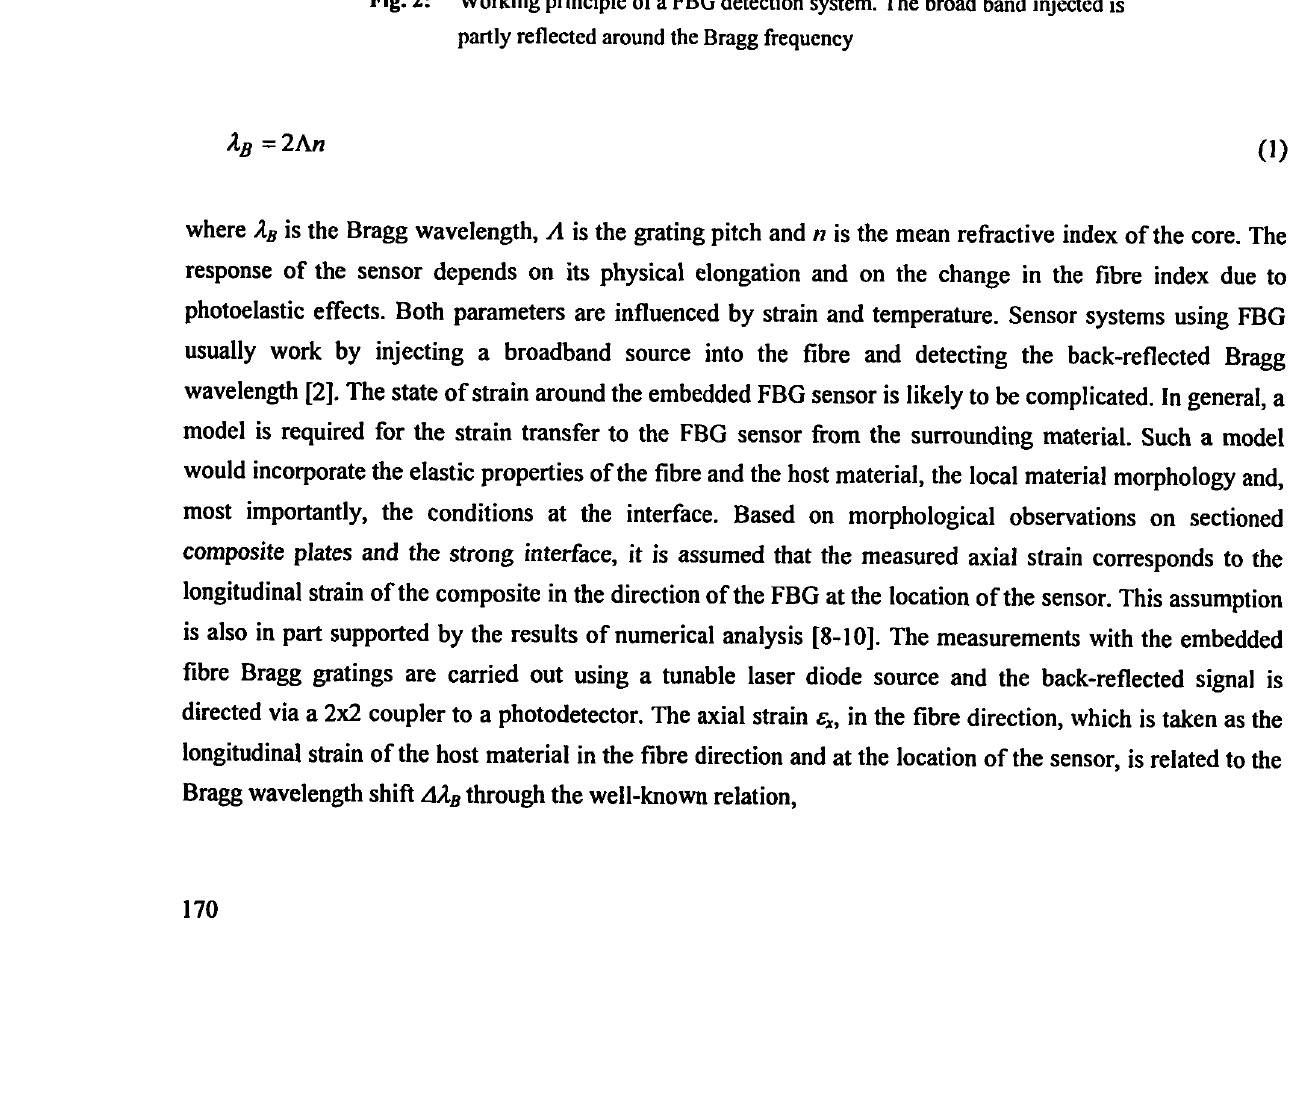
Fig. 2: Working principle of a FBG detection system. The broad band injected is partly reflected around the Bragg frequency